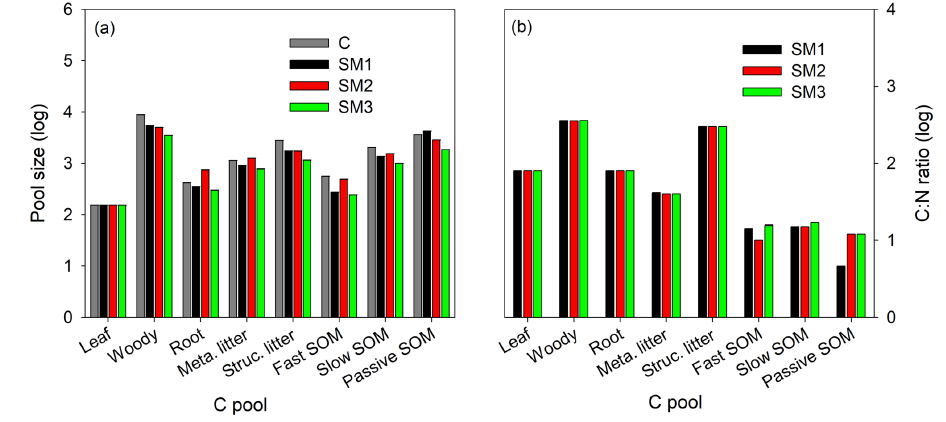
Figure 5. The annual average sizes of carbon pools (a) at the steady state during 1996–2007 for the C-only version and the three C–N schemes (SM1, SM2, and SM3), and the C : N ratio (b) of each carbon pool for the three C–N schemes (SM1, SM2, and SM3) in the TECO-CN model.